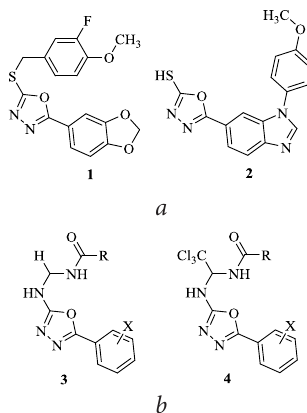
Fig. 1. The structures of some inhibitors of